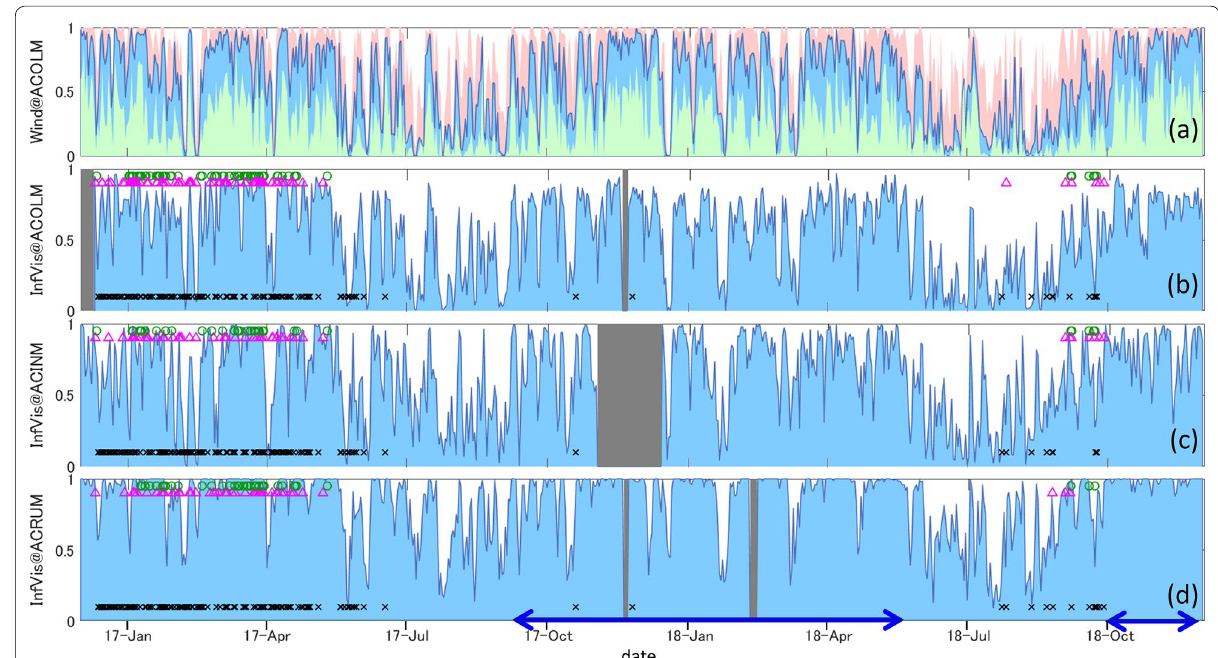
Fig. 7 The visibility of infrasound signals (InfVis) at NRV evaluated by the wind data at the OLLETA weather station close to ACOLM ( a ) and by the infrasound data at ACOLM ( b ), ACINM ( c ), and ACRUM ( d ). a The daily fraction of wind speed data smaller than the threshold values of 2 m/s (green), 4 m/s (blue), and 8 m/s (pink). b – d The InfVis is shown by blue, and the periods of missing data are shaded. The events to which the associated infrasound signals are detected and failed at the individual station are indicated with the magenta triangles and the black crosses, respectively (see Additional file 2: Table S2.1). The green circles are the unconfirmed events (see Additional file 2: Table S2.2). The blue arrows at the bottom show the periods of low infrasound activity, confirmed by the high